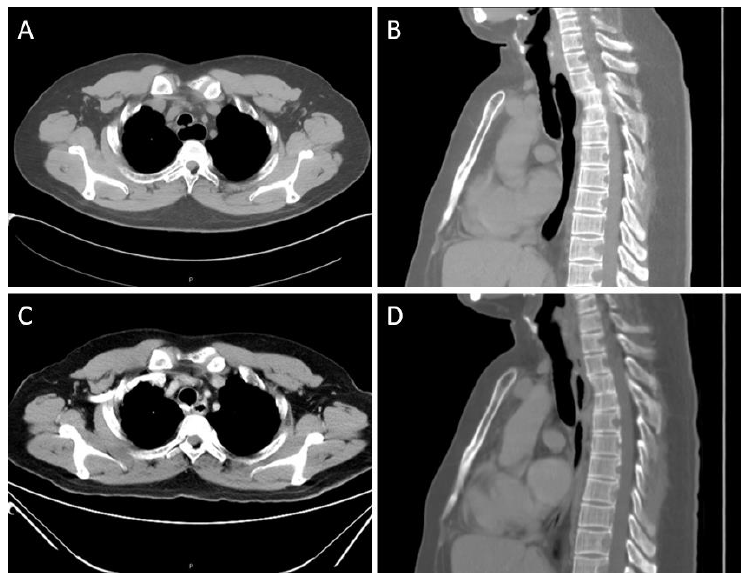
Figure 1. Preoperative and postoperative CT scans of the patient. ( A ) The axial view of pre-op scan showed a fistulous tract between the trachea and the dilated esophagus. ( B ) The sagittal view of pre-op scan showed the fistula at T2 level. ( C ) The axial view of the post-op scan six months later demonstrated a normalized esophageal diameter. ( D ) The sagittal view of the post-op scan showed no evidence of a residual fistula.